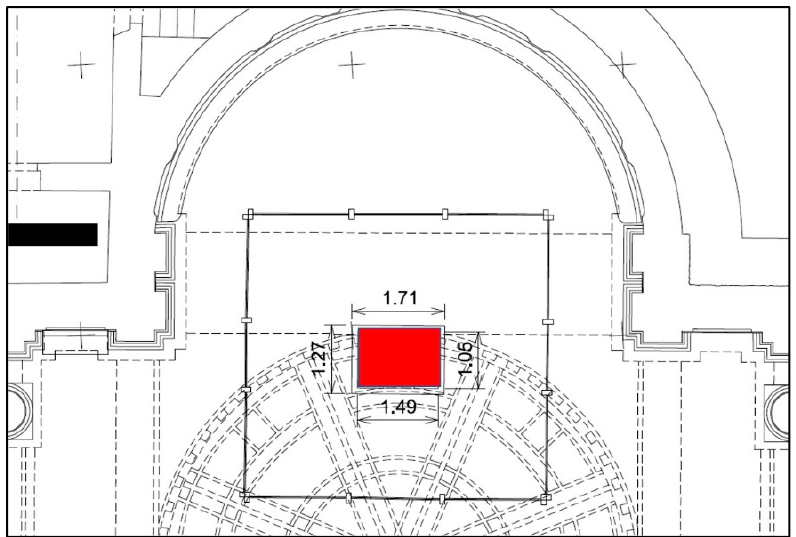
Figure 2. Top view map of the exhibition area in the Galleria dell’Accademia. In red is David’s pedestal. Quotes are in metres.